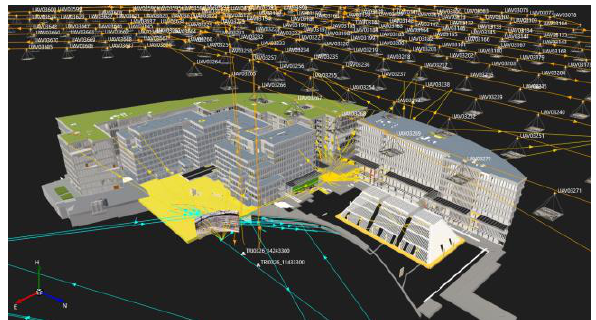
Figure 2 . BIM model, UAV images and GNSS track, scan data referenced to TPS observations (yellow vectors), GNSS observations (light blue